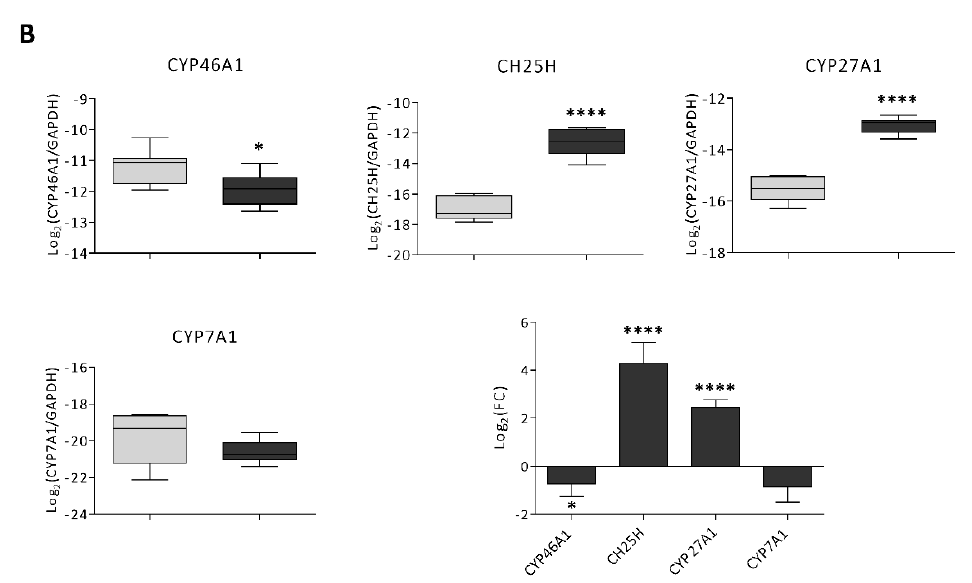
Figure 4. Quantification of oxysterols and gene expression analysis of the enzymes involved in cholesterol oxidation. ( A ) The amount of the oxysterols 24-hydroxycholesterol (24-OHC), 25-hydroxycholesterol (25-OHC), 27-hydroxycholesterol (27-OHC), 7 α -hydroxycholesterol (7 α -OHC), 7 β -hydroxycholesterol (7 β -OHC), and 7-ketocholesterol (7-KC) were quantified by gas chromatography-mass spectrometry (GC-MS) in ApoE3 and ApoE4 immortalized mouse astrocytes. Data are expressed as mean values ± SD of three different experiments ( n = 9, Student’s t -test). **** p < 0.0001, *** p < 0.001 vs. ApoE3 astrocytes. ( B ) Gene expression levels of the enzymes cholesterol 24-hydroxylase (CYP46A1), cholesterol 25-hydroxylase (CH25H), cholesterol 27-hydroxylase (CYP27A1), and cholesterol 7 α -hydroxylase (CYP7A1) were analysed in ApoE3 and ApoE4 immortalized mouse astrocytes. Gene expression results were normalized to GAPDH expression levels. Data are shown either as Log 2 (gene/GAPDH) or as Log 2 (FC). Data are expressed as mean values ± SD of three different experiments ( n = 8, Student’s t -test). **** p < 0.0001, * p < 0.05 vs. ApoE3